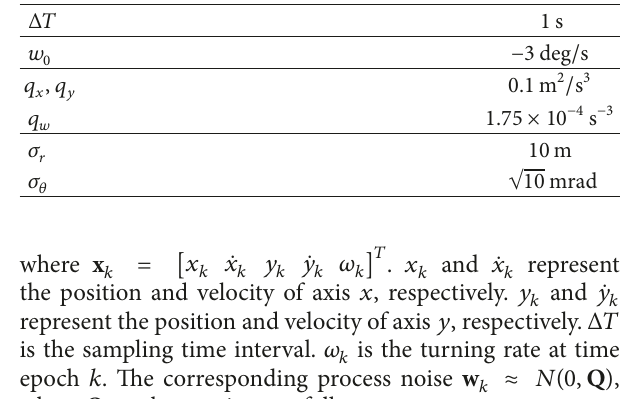
Table 2: Parameter setting for the